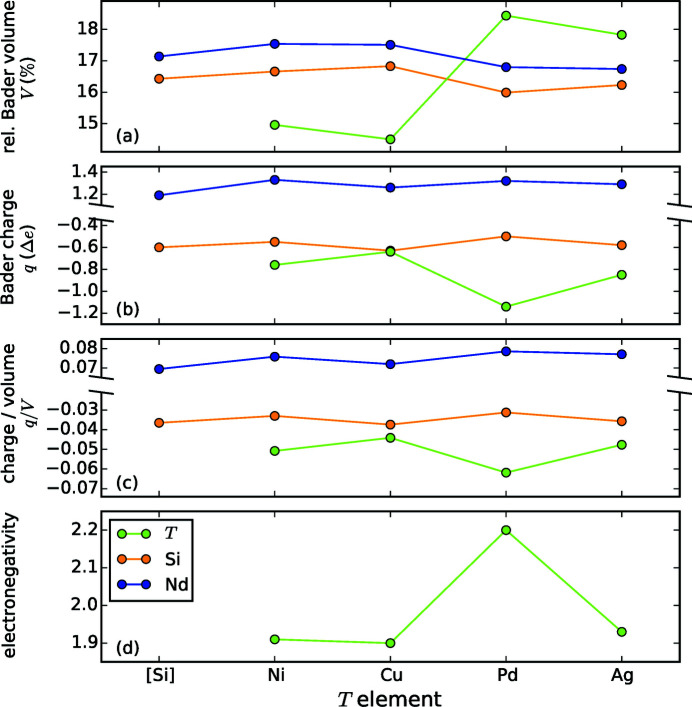
The different charges of Si and the R element are caused by the different Bader volumes ascribed to the elements as well as the different electronegativities of T.